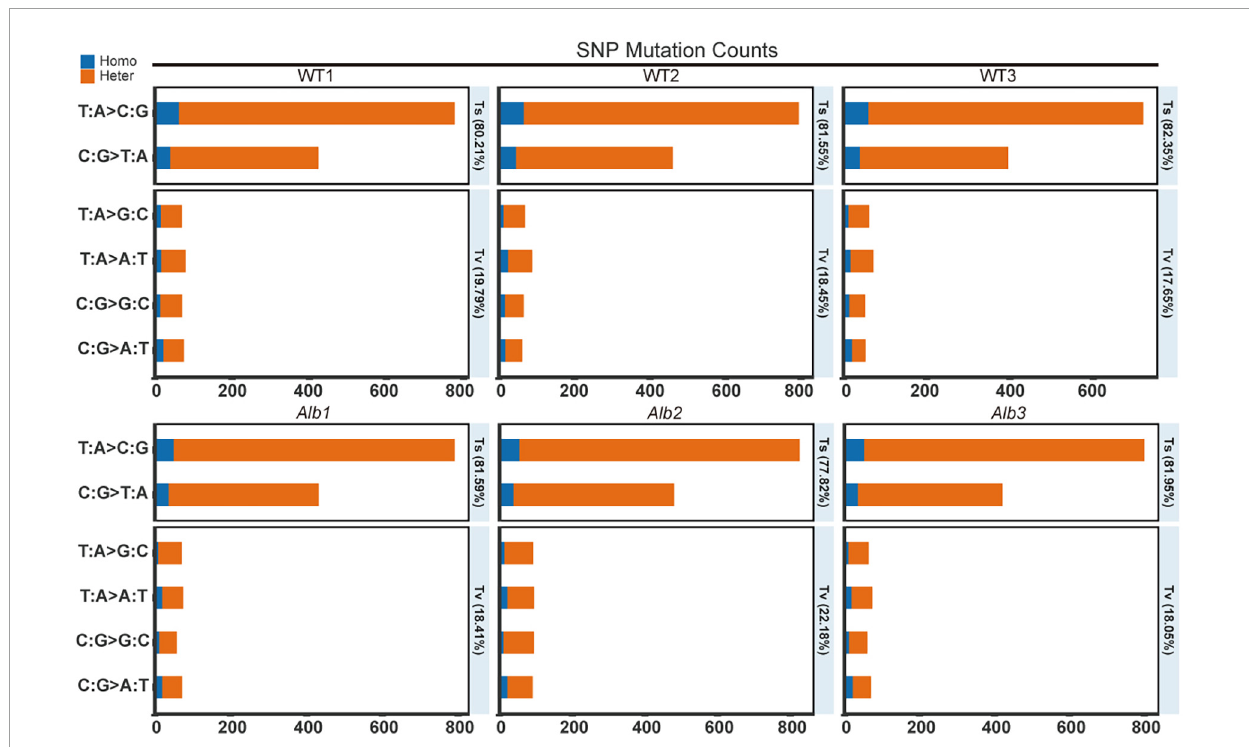
FIGURE2 SNP mutation counts analysis between WT and Alb . Homo, homozygous SNP sites; Heter, heterozygous SNP sites; WT1–WT3 and Alb1–Alb3, indicate three biological